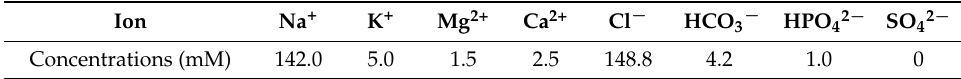
Table 1. Ion concentrations of the stimulated body fluid (SBF) used for the in vitro apatite-forming ability